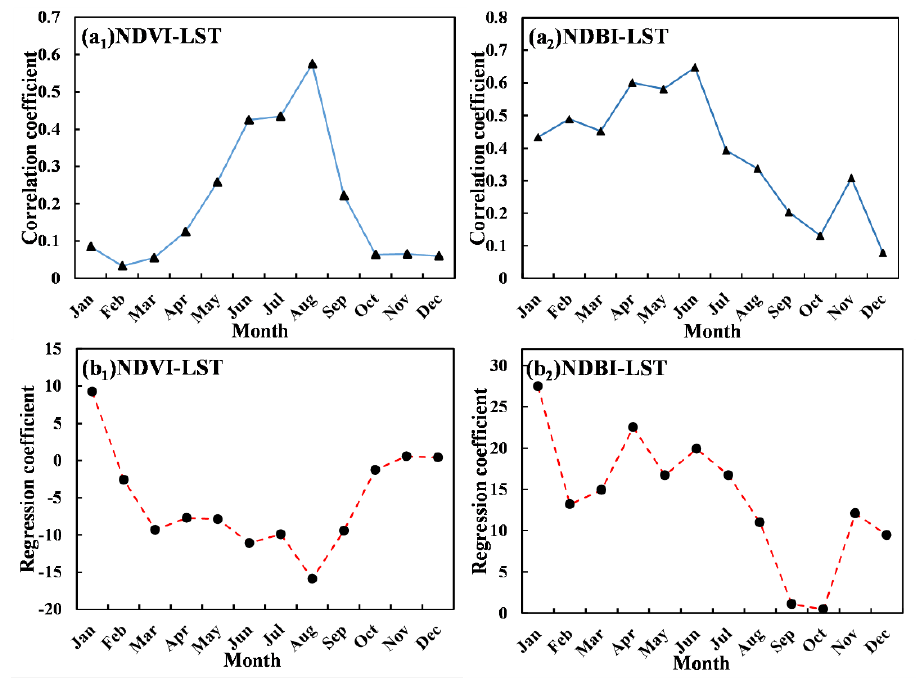
Figure 16. Relationships between Landsat NDVI, NDBI, and LST from monthly series of 2013.